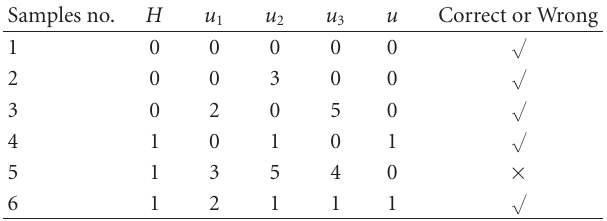
Table 3: Selected samples and fusion result. Samples